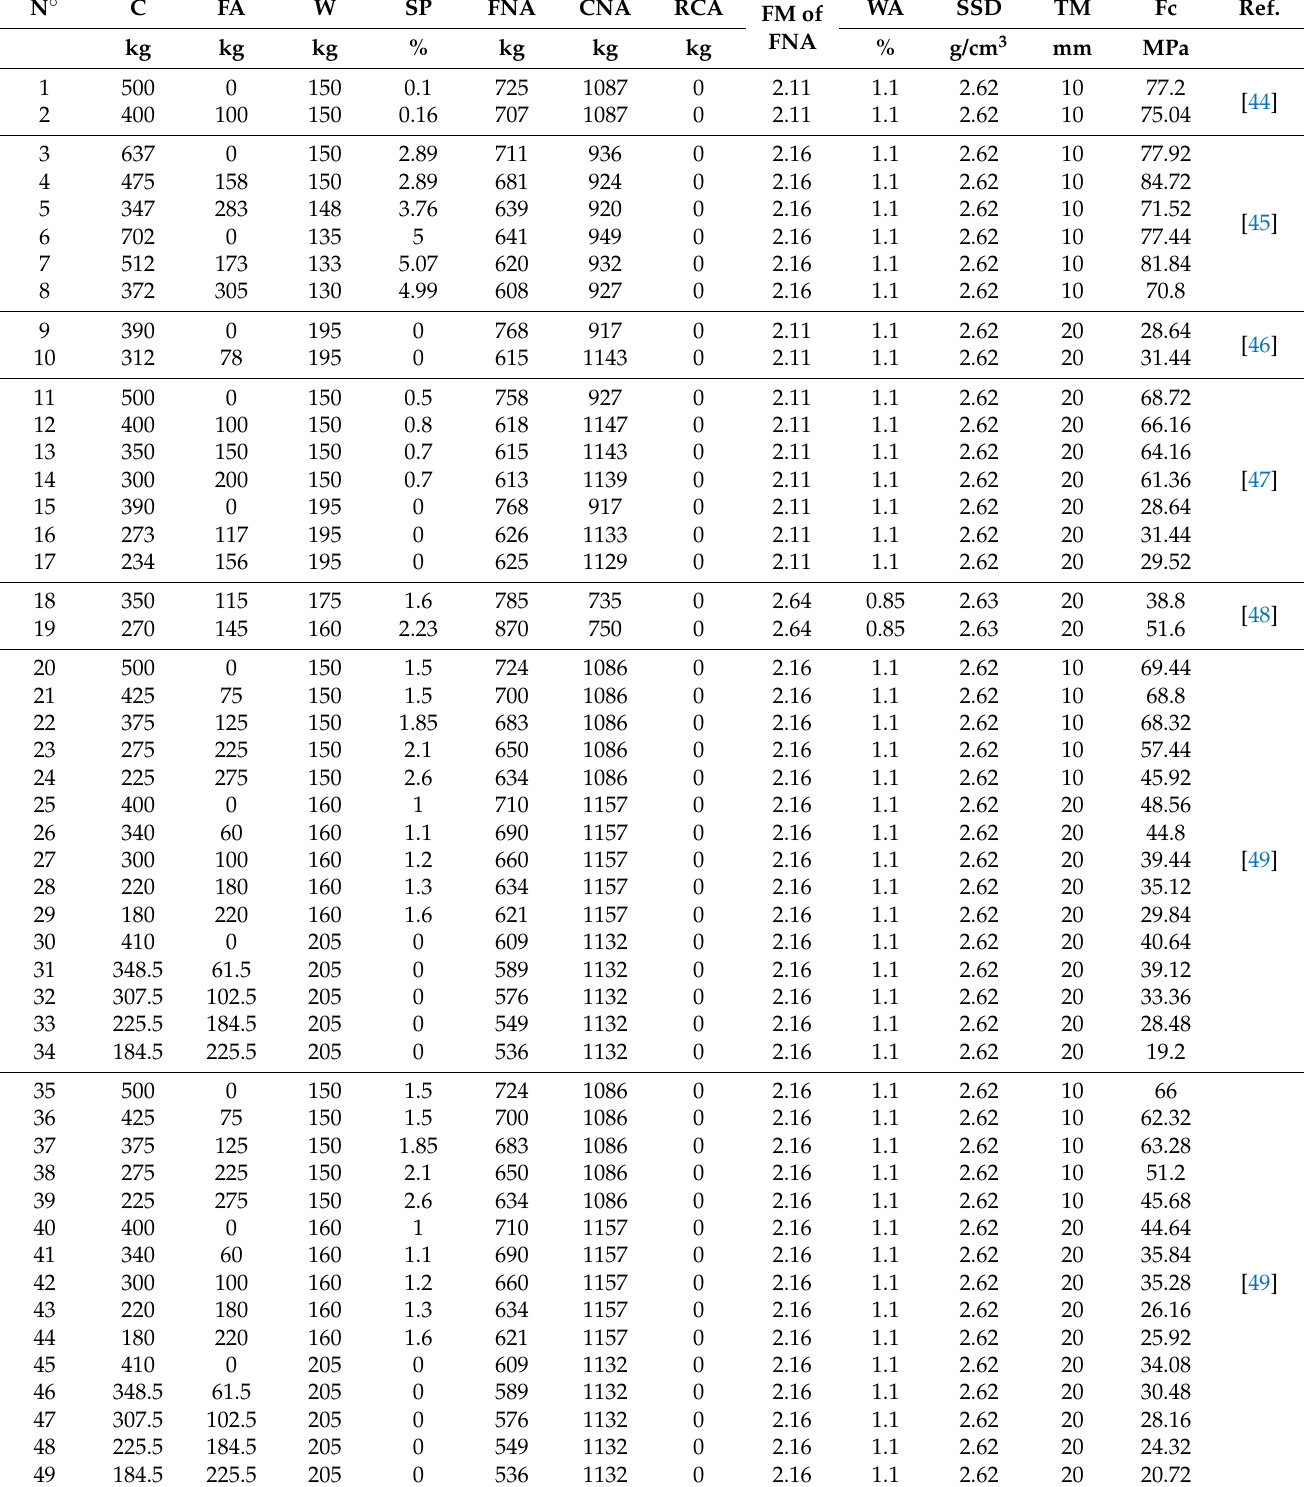
Table A1. Data base with 177 mixes selected from 15 studies on the effect of incorporating